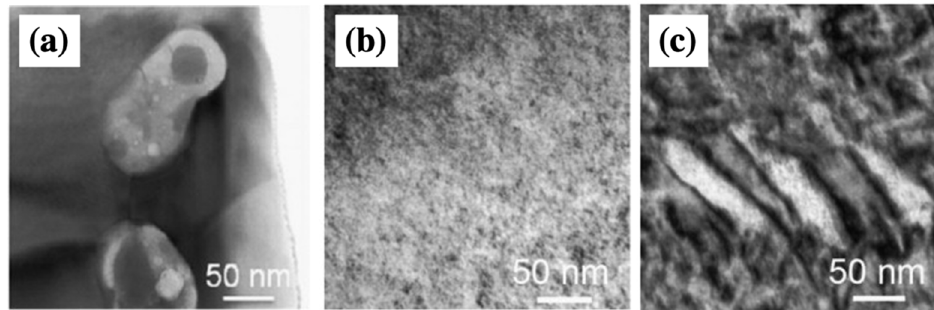
Figure 12. Bright-field TEM image of domain structure; ( a ) 0.40BaTiO 3 –0.60Bi(Mg 1/2 Ti 1/2 )O 3 , ( b ) 0.45BaTiO 3 –0.20Bi(Mg 1/2 Ti 1/2 )O 3 –0.35BiFeO 3 , and ( c ) 0.30BaTiO 3 –0.10Bi(Mg 1/2 Ti 1/2 )O 3 –0.60BiFeO